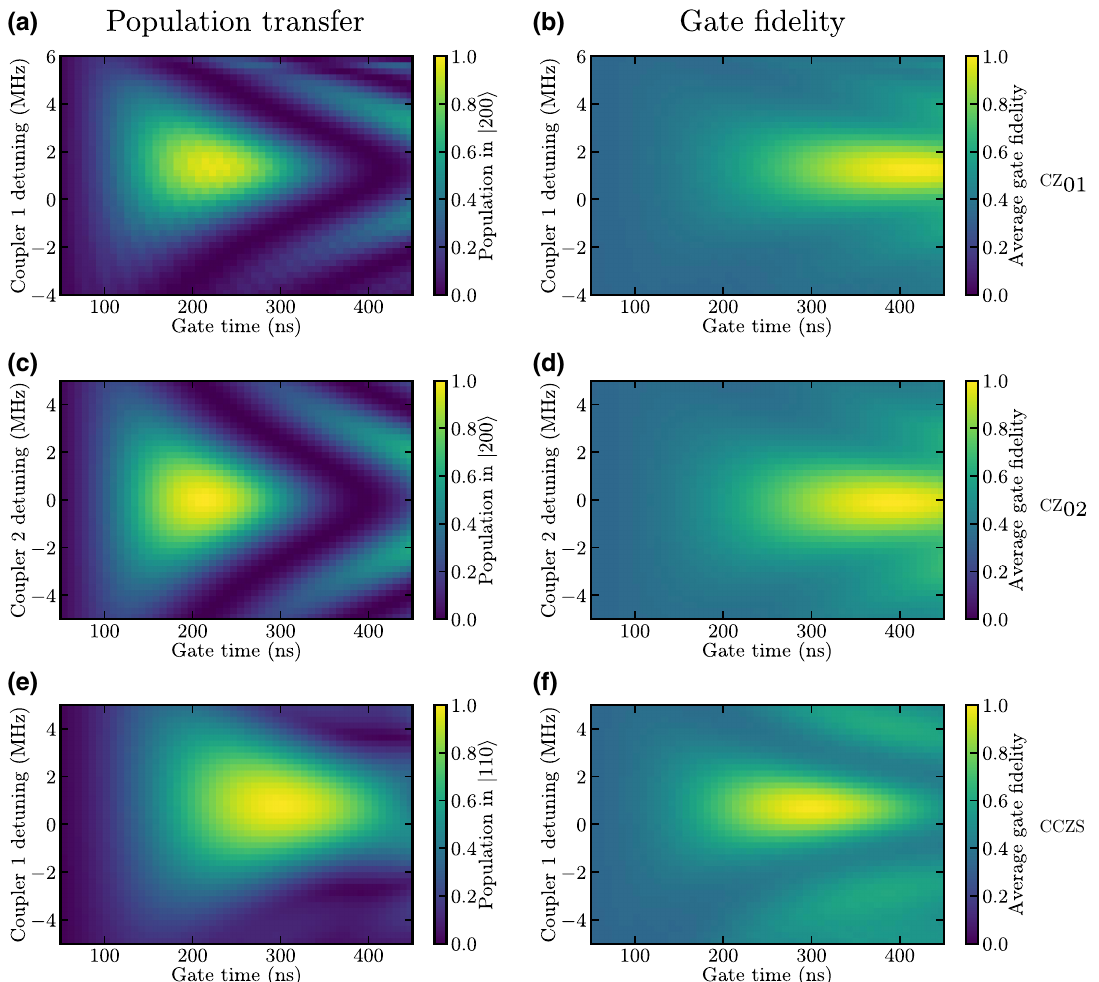
FIG. 10. Calibrating the CCZS gate with tunable couplers. (a) Population in | 200 (cid:2) as a function of gate time and the detuning between and the frequency of the transition | 110 (cid:2) ↔ | 200 (cid:2) when calibrating the CZ 01 gate by initializing the the modulation frequency ω (cid:15) 1 system in | 110 (cid:2) . (b) The gate fidelity for the CZ 01 gate for the parameters in (a). (c) Population in | 200 (cid:2) as a function of gate time and the frequency of the transition | 101 (cid:2) ↔ | 200 (cid:2) when calibrating the CZ 02 and the detuning between the modulation frequency ω (cid:15) 2 gate by initializing the system in | 101 (cid:2) . (d) The gate fidelity for the CZ 02 gate for the parameters in (c). (e) Population in | 110 (cid:2) as a and the frequency of the transition | 110 (cid:2) ↔ | 200 (cid:2) when function of gate time and the detuning between the modulation frequency ω (cid:15) 1 , but in this plot it is calibrating the CCZS (π/ 2, π , 0 ) gate by initializing the system in | 101 (cid:2) . During the calibration, we also vary ω (cid:15) 2 kept fixed. (f) The gate fidelity for the CCZS (π/ 2, π , 0 ) gate for the parameters in